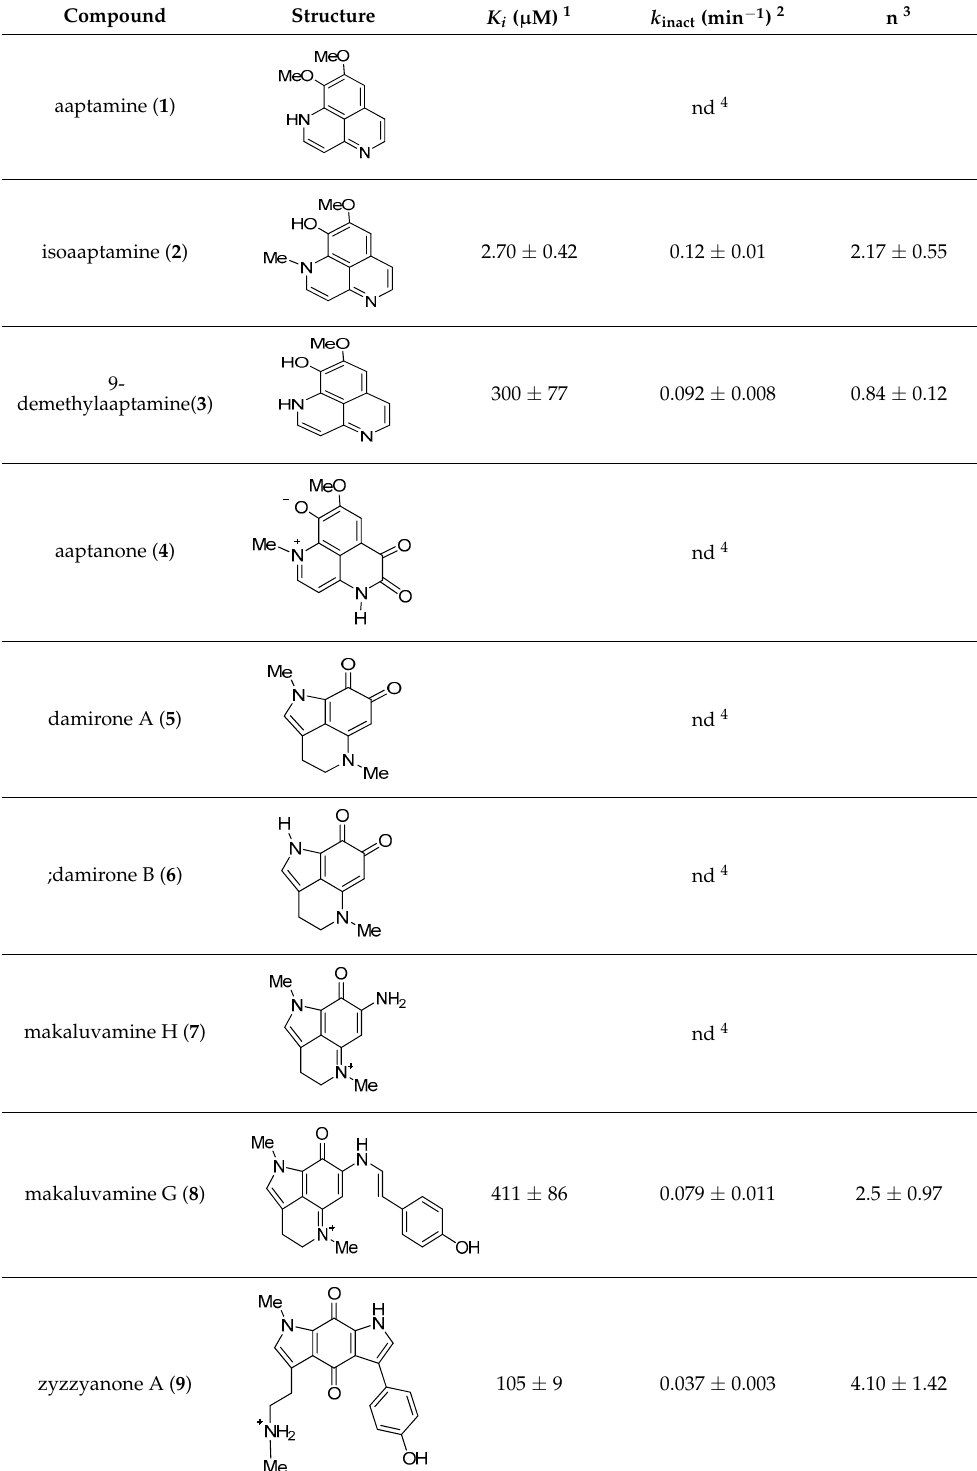
Table 2. Structures of tested spongean alkaloids and α -PsGal inhibition constants for 2 , 3 , 8, and 9. Compound Structure